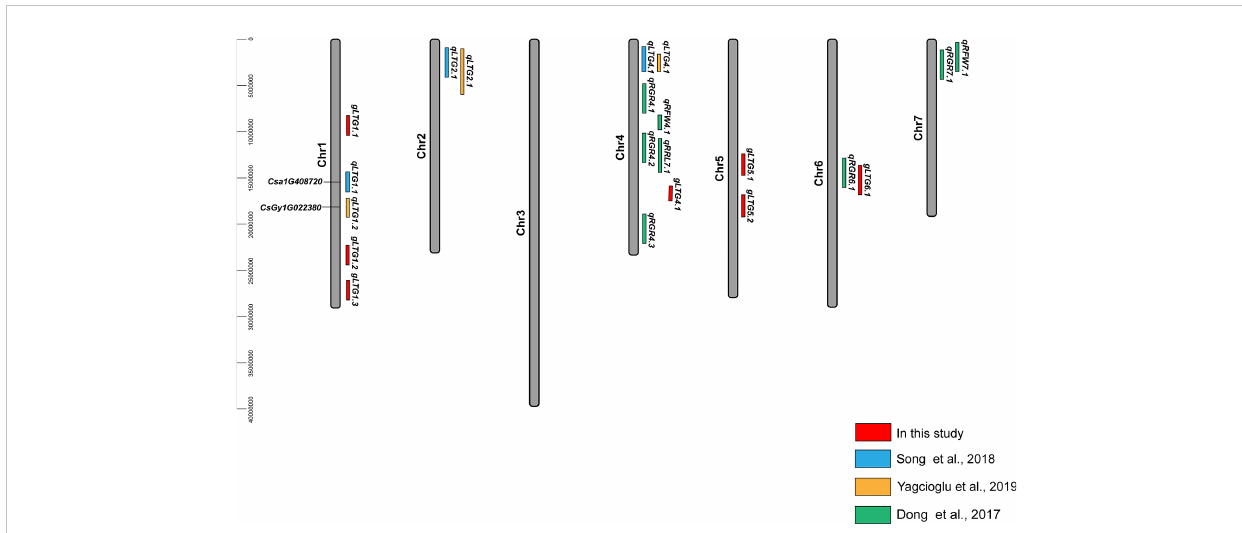
(Figure 7D). Two SNPs in the third exon caused a base change from A-to-T and from A-to-G, which resulted in amino acid change from Thr ! Ser and Ile ! Val, respectively (Figure 7D). Two SNPs located in the fourth exon, led to a synonymous mutation. All 47 sensitive lines were (Hap1), carried the haplotype “ AAGG ” while 24% of the